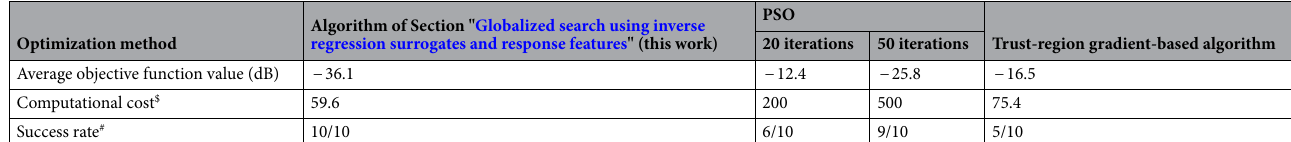
Table 3. Optimization results for Structure II. $ The cost calculated as the number of EM simulations of the structure under design, averaged over ten algorithm runs. # Number of algorithms runs with the operating frequency allocated with sufficient accuracy, i.e., to satisfy U ( x *, F ) ≤ U local .